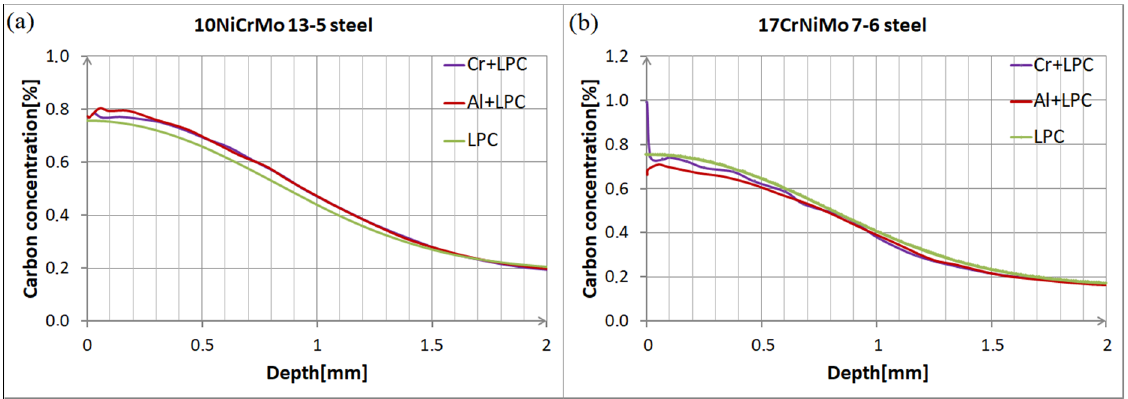
Figure 4. Profile distribution of carbon for 10NiCrMo 13-5 ( a ) and 17CrNiMo 7-6 ( b ) steels after low pressure carburizing only, after low pressure carburizing with chromium plating and after low pressure carburizing with aluminum coating.